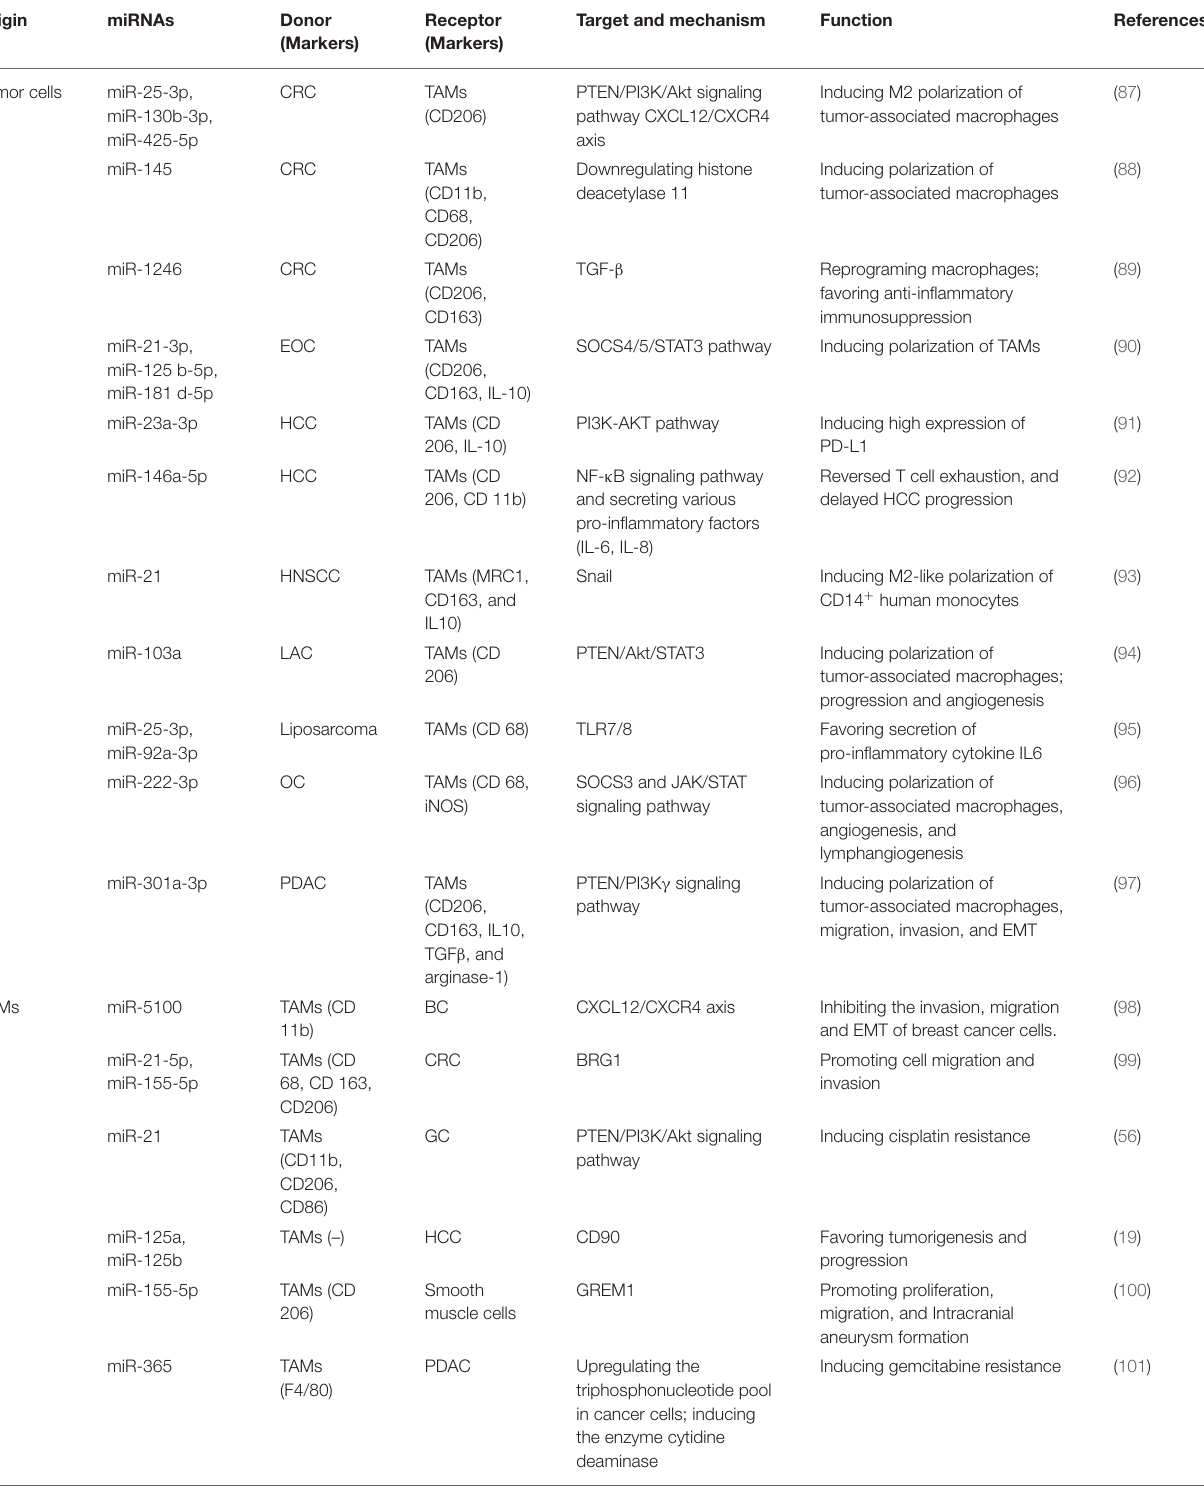
TABLE 2 | Exosomal miRNAs mediating the communication between tumor cells and TAMs.